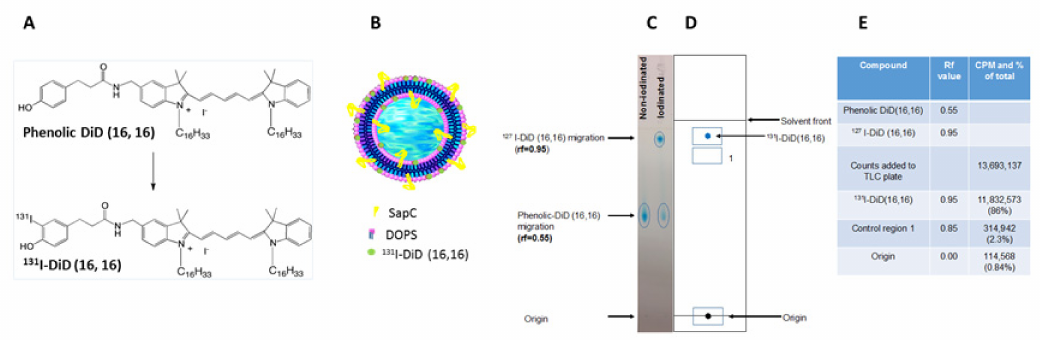
Figure 5. Thin layer chromatography (TLC) schematic depiction of 127 I-DiD (16,16) and 131 I-DiD (16,16) samples. ( A ) Schematic of iodination of DiD (16,16). ( B ) 131 I-DiD (16,16)-SapC-DOPS model. ( C ) Non-iodinated and 127 I-DiD (16,16) samples; 1 µ g of each were spotted at the origin of the TLC plate. Ovals indicate the migration of indicated samples. ( D ) Schematic representation of 131 I-DiD (16,16) migration. Squares represent scraped regions from TLC plate. ( E ) Table showing the retention factor (Rf) values of non-iodinated and 127 I-DiD (16,16) samples and counts per minute (CPM) for 131 I-DiD